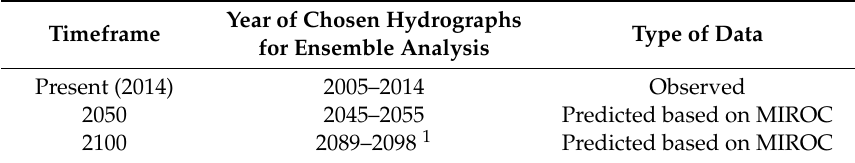
Table 3. Fraser River hydrograph chosen for the ensemble